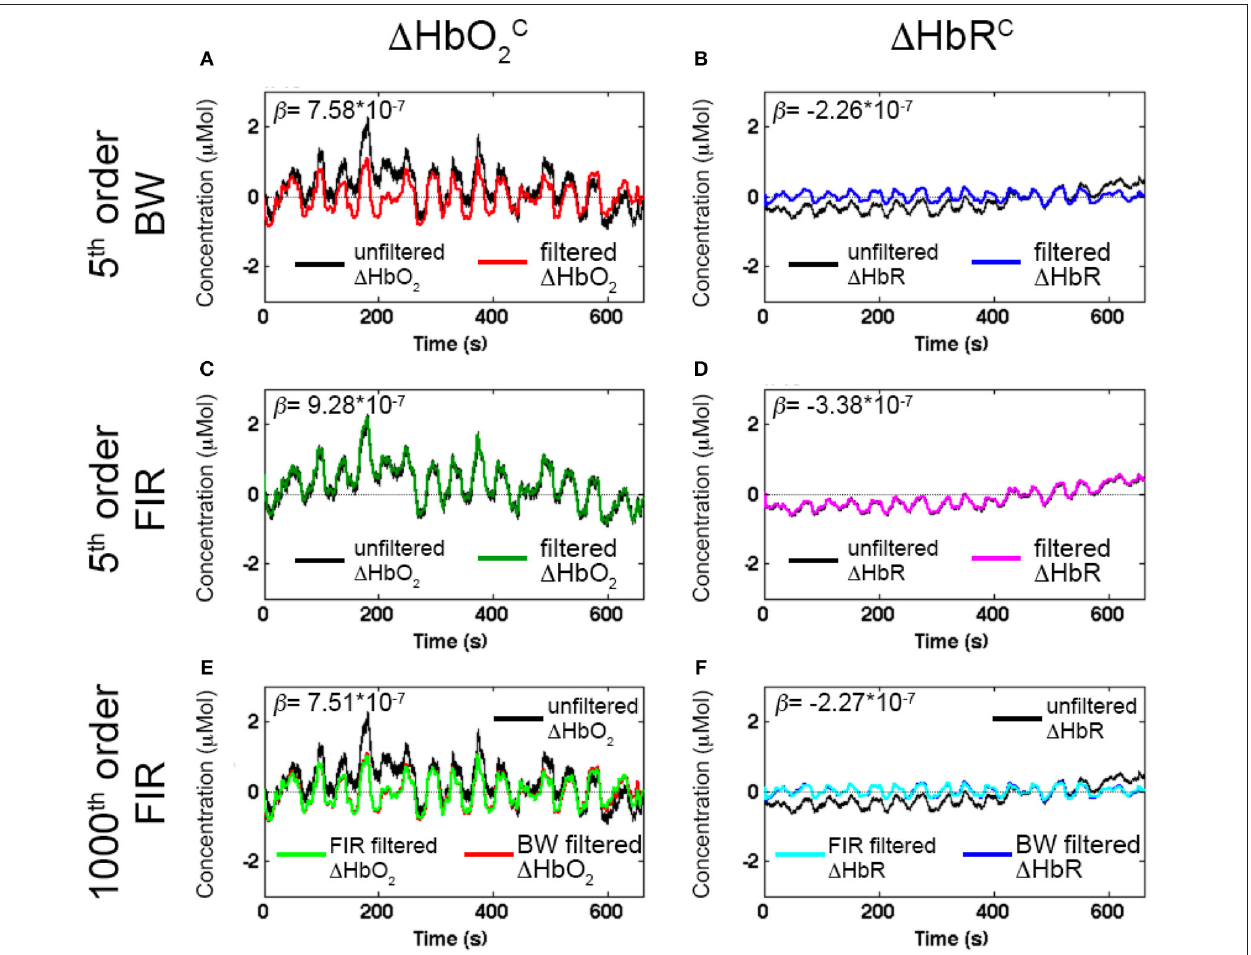
FIGURE 7 | Examples of filtered 1 HbO C 2 and 1 HbR C signals with Amplitude 1 for one channel of a representative participant using a 5th order BW BP filter ( A,B , red and blue signals), a 5th order FIR BP filter ( C and D , green and magenta signals), and a 1000th order FIR BP filter ( E,F , light green and cyan signals) within the range [0.01, 0.2] Hz. The estimated β -values from the GLM fitting of the filtered 1 HbO C 2 and 1 HbR C are included. The reference β are 8 × 10 − 7 for 1 HbO 2 and of − 2.7 × 10 − 7 for 1 HbR.